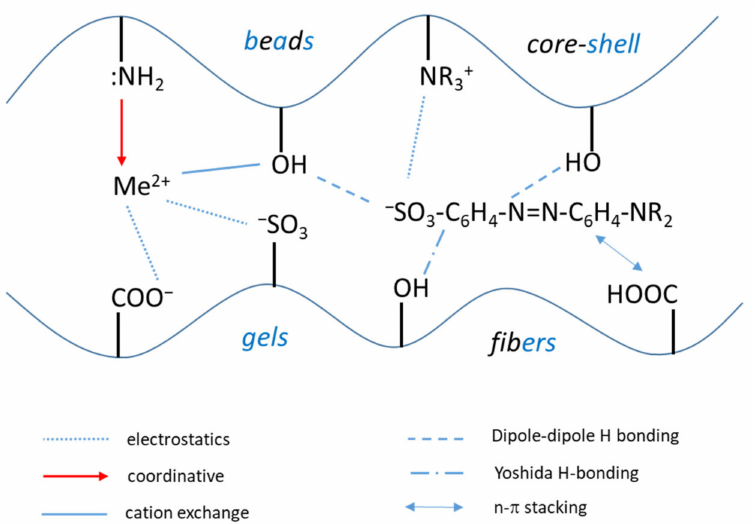
Figure 4. Principal types of interactions between inorganic (Me 2+ ) and organic pollutants with composite polyelectrolyte sorbents functional